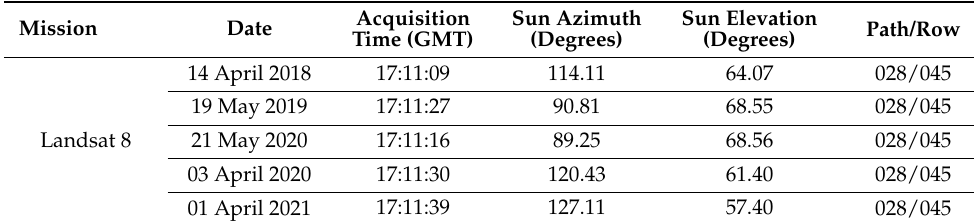
Table A1. Landsat 8 OLI/TIR images for the different dates of pre- and post-fires.